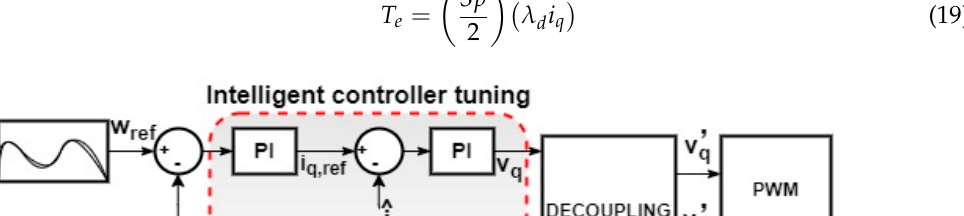
Figure 5. Decoupled control scheme of the electric vehicle driven by PMSM. Each stage of the figure above is discussed in detail, as it will be shown below. 4.1. Inverter Model The output of the decoupling block is supplied to a the three-phase SPWM inverter whose transfer function is given as follows: